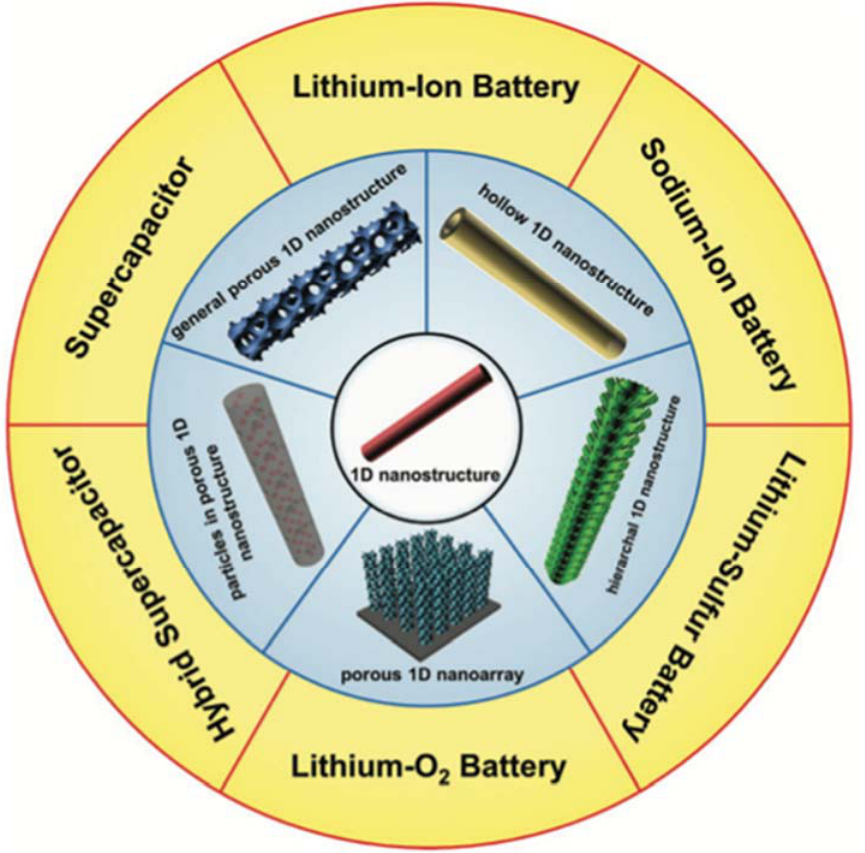
Figure 30. Porous 1D nanostructures and potential applications in electrochemical energy storage. Reprinted with permission from reference [166].